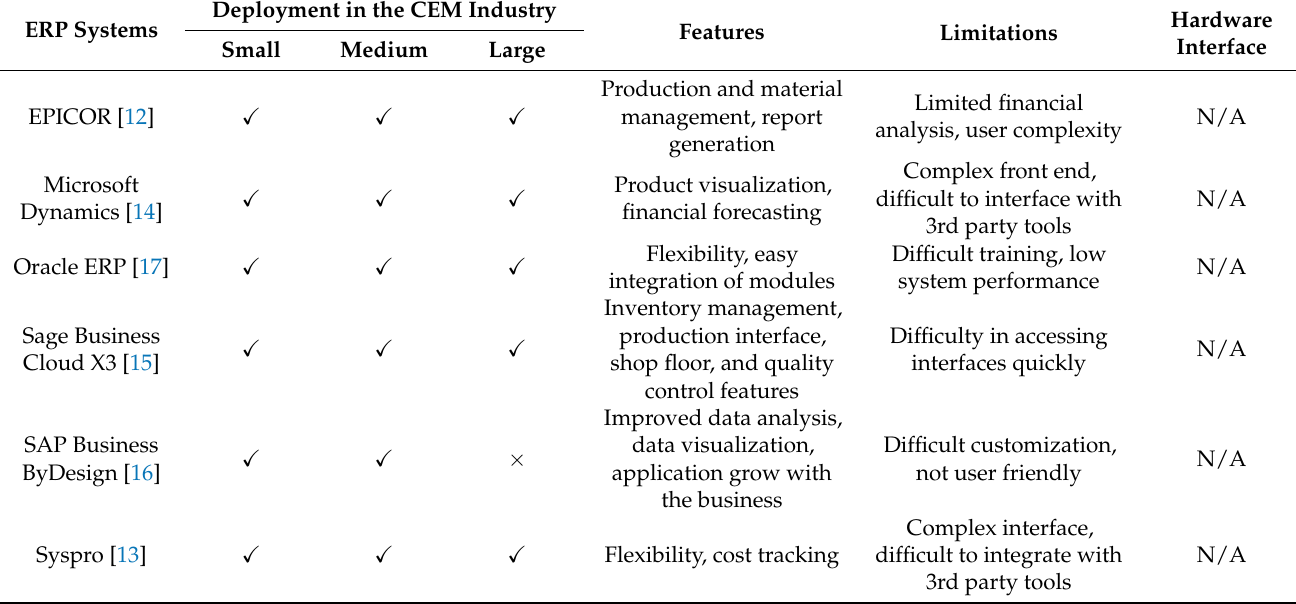
Table 1. Enterprise resource planning systems implemented in consumer electronic manufacturing companies. ERP